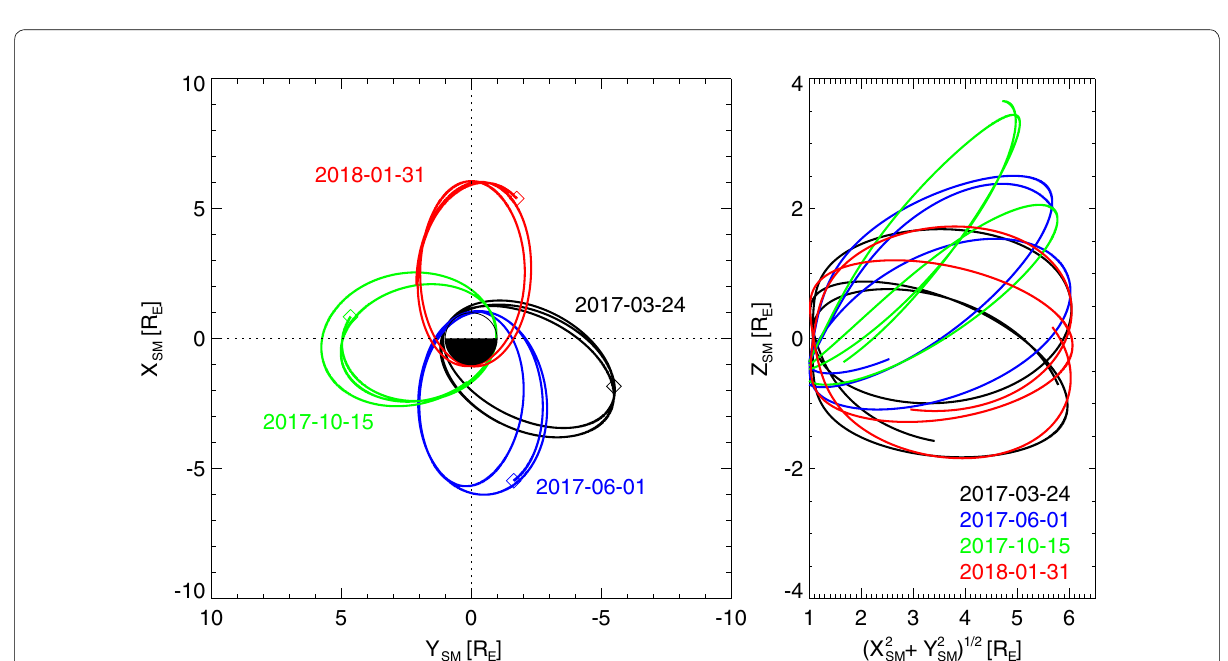
Fig. 3 Sample orbits of the ERG satellite. Black: March 24, 2017, Blue: June 1, 2017, Green: October 15, 2017, and Red: January 31,